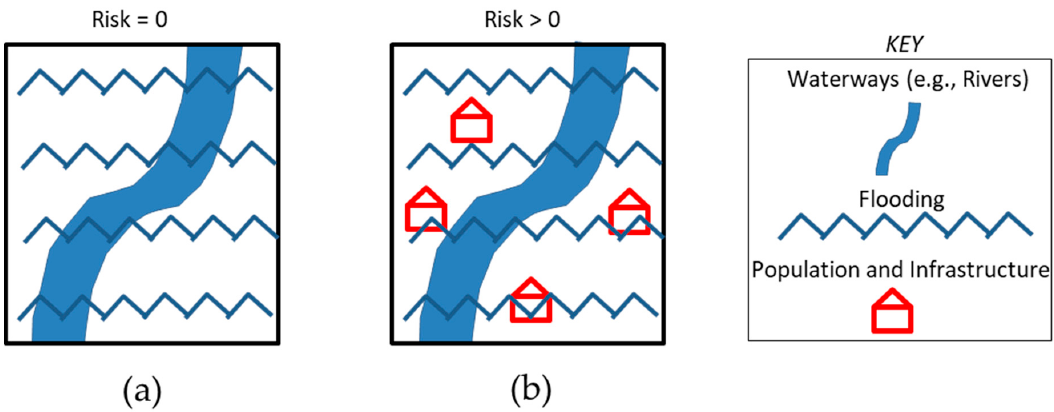
Figure 1. Understanding flooding risk. ( a ) Flooded area is “empty”, thus flood risk is zero; ( b ) Flooded are contains population and infrastructure, thus flood risk is greater than zero.